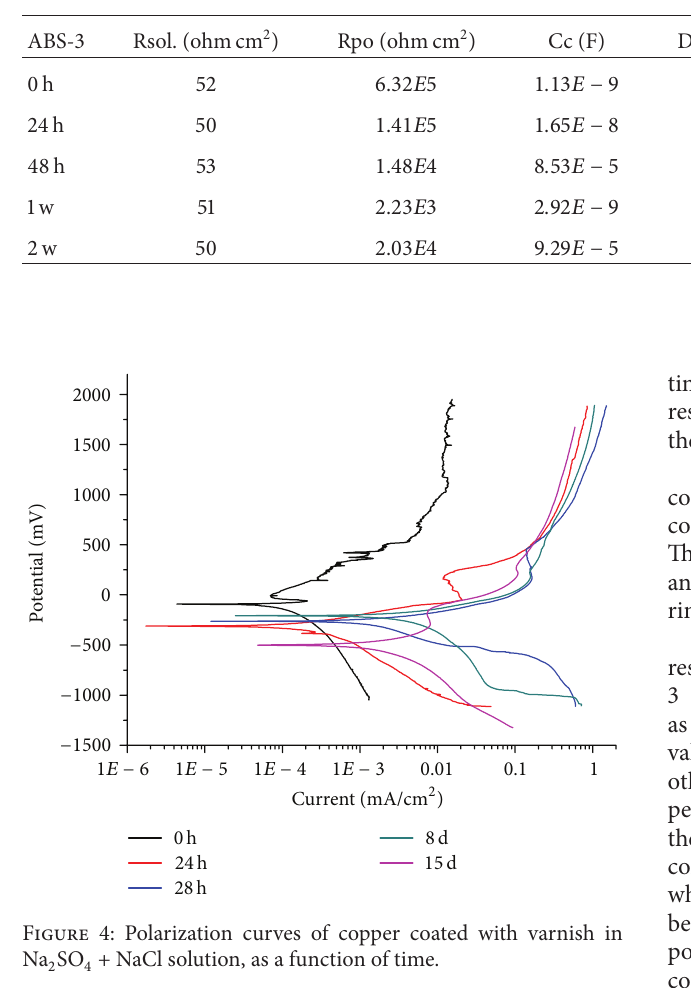
SO + 3 wt% NaCl solution in time. 2 4